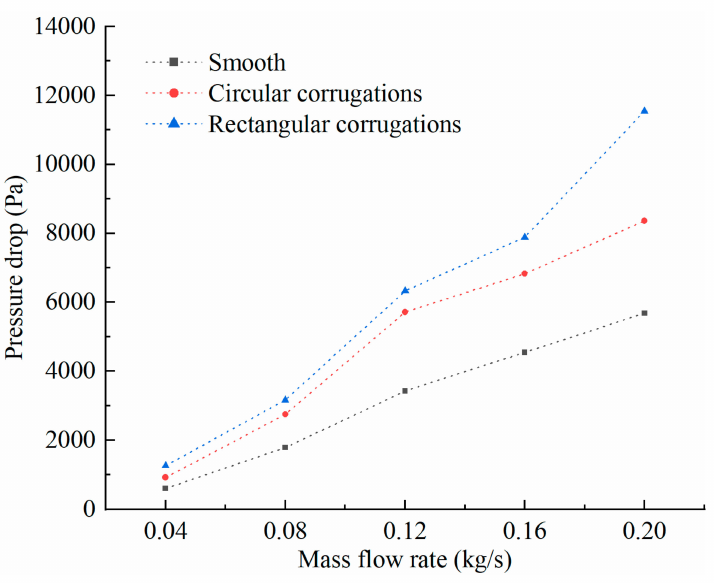
Figure 9. Impact of mass flow rate on the total pressure drop for all the tubes. This variation happened with the same gradient for both the corrugated and smooth tubes. For the mass flow rate of 0.04–0.20 kg/s, the pressure drop of corrugated